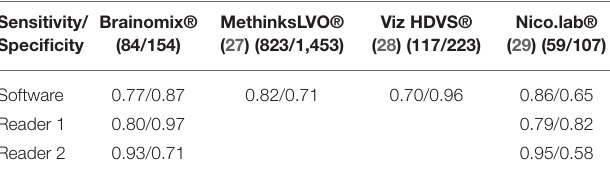
TABLE 3 | Comparison of different hyperdense artery sign detection algorithms introduced so far in the literature (March 2021). Sensitivity/ Brainomix® Specificity